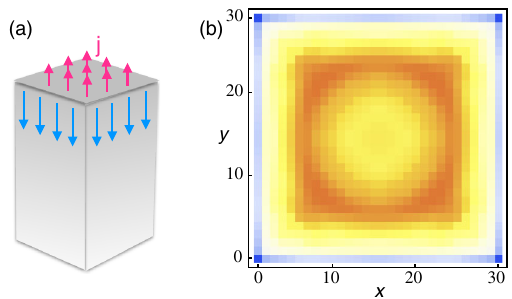
FIG. 7. Equilibrium current density in the Weyl semimetal wire under torsion. (a) Schematic depiction of the bulk or surface current flow. (b) Ground-state current density computed from the lattice model, Eqs. (2.4) and (2.9), at chemical potential μ ¼ 5 meV. Warm (cold) colors represent positive (negative) current density j . The ring-shaped inhomogeneity in j apparent in the bulk of the wire reflects Friedel-like oscillations in electron wave functions caused by the presence of the